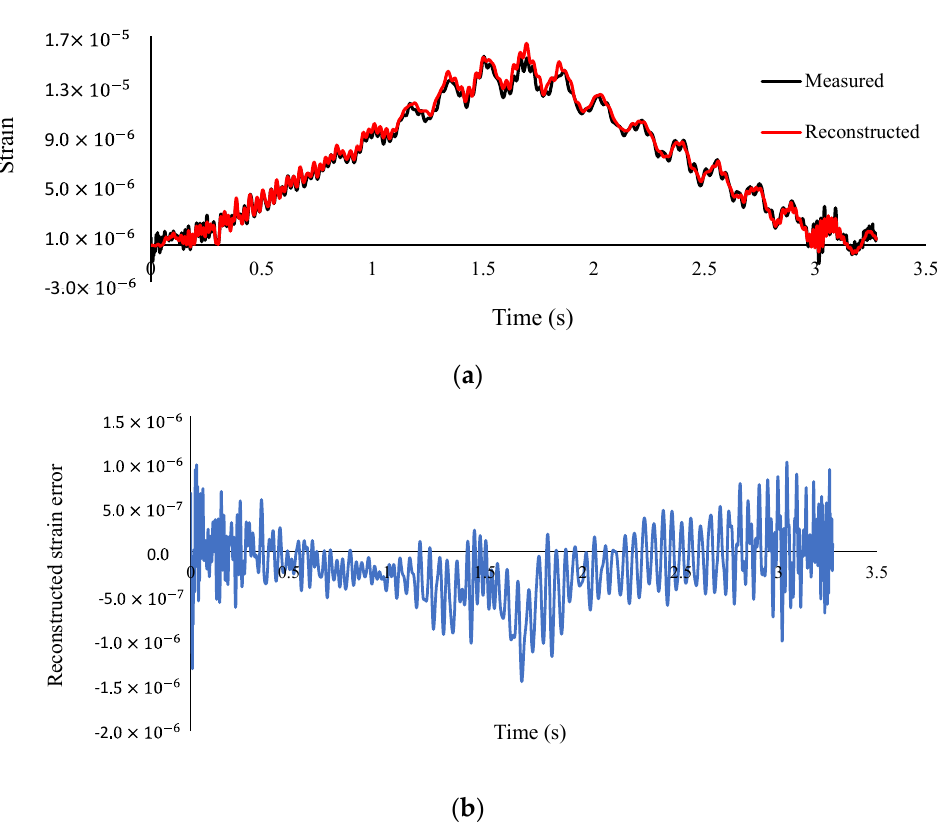
Figure 19. ( a ) Measured and reconstructed strain at mid-span ( b ) Error of reconstructed strain (Damage case 2—speed 0.94 m/s—sampling frequency 800 Hz).